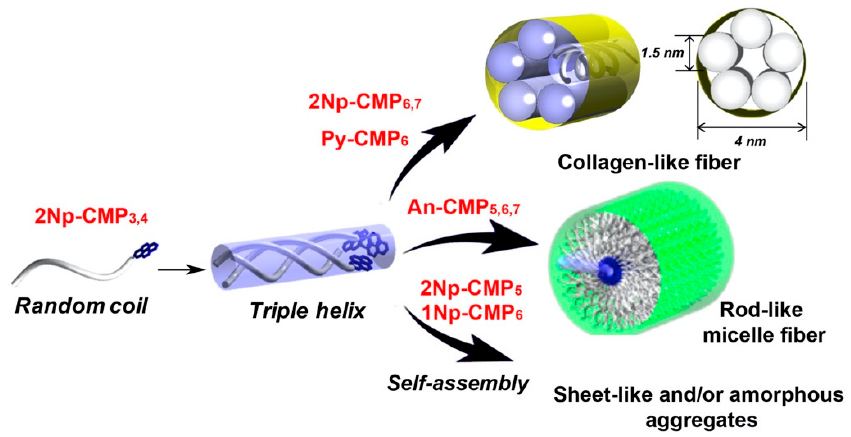
Figure 6. Schematic illustration of a hierarchical self-assembly model for a series of CMPs bearing various aromatic groups.